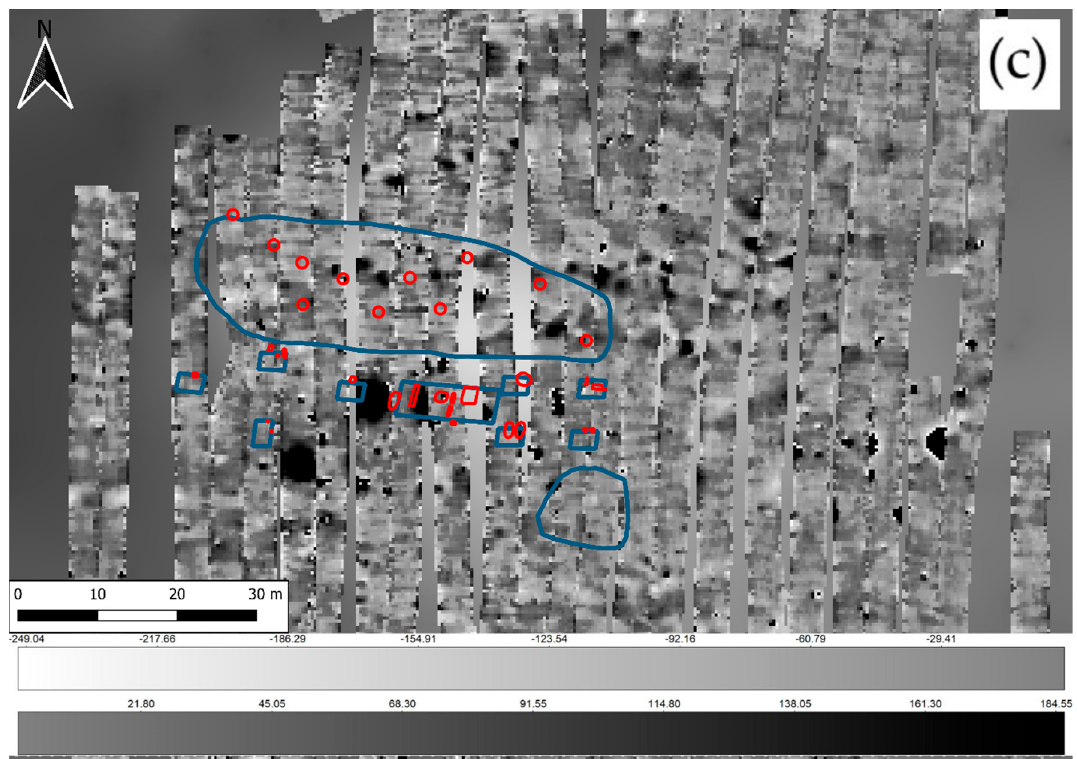
Figure 14. Comparison between archaeological and geophysical results. ( a ) Georeferencing of the archaeological surveys and reproduction of the results in shape format (Source: Fuentes Sánchez and Benítez de Lugo Enrich, 2021); ( b ) Comparison between the archaeological surveys and the results of the Stream X georadar. It can be seen how the geophysical anomalies coincide with the excavated mural assemblages; ( c ) Comparison with the magnetic results. Coincidences between both results can be observed.